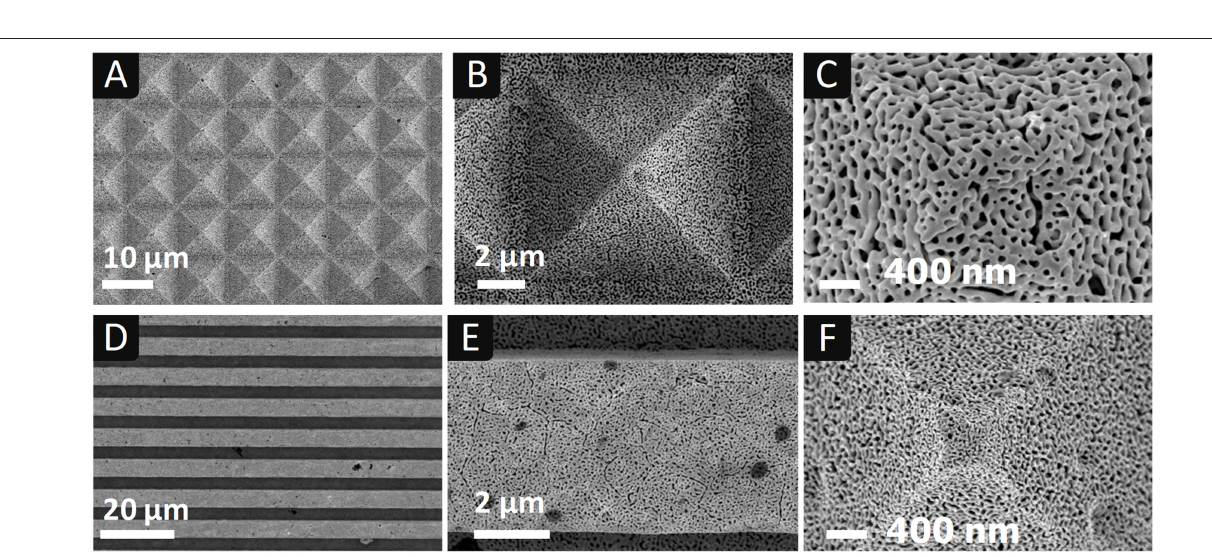
FIGURE 3 | SEM images at different magnification of np-Au electrodes dealloyed chemically (A–E) and electrochemically (F) , with two different surface patterns: (A–C,F) array of square based pyramids (10 × 10 µ m 2 × 7 µ m depth); (D,E) parallel lines with rectangular cross section (5 × 5 µ m 2 (width × height), spacing of 4 µ